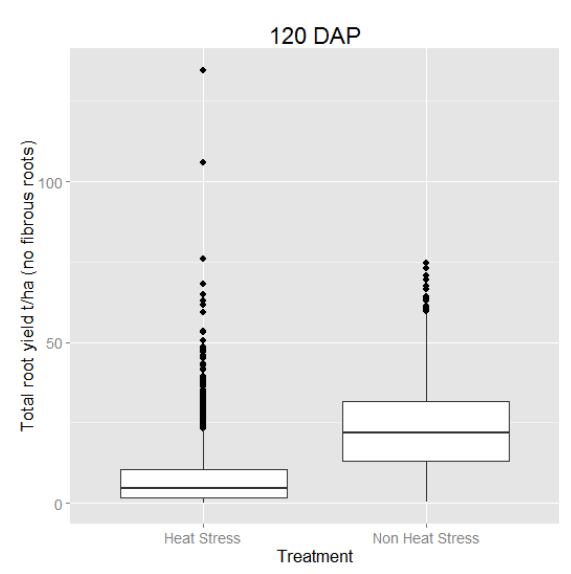
Figure 12: Total sweet potato root yield (t/ha), with and without heat stress (source: B. Heider, pers. comm.)